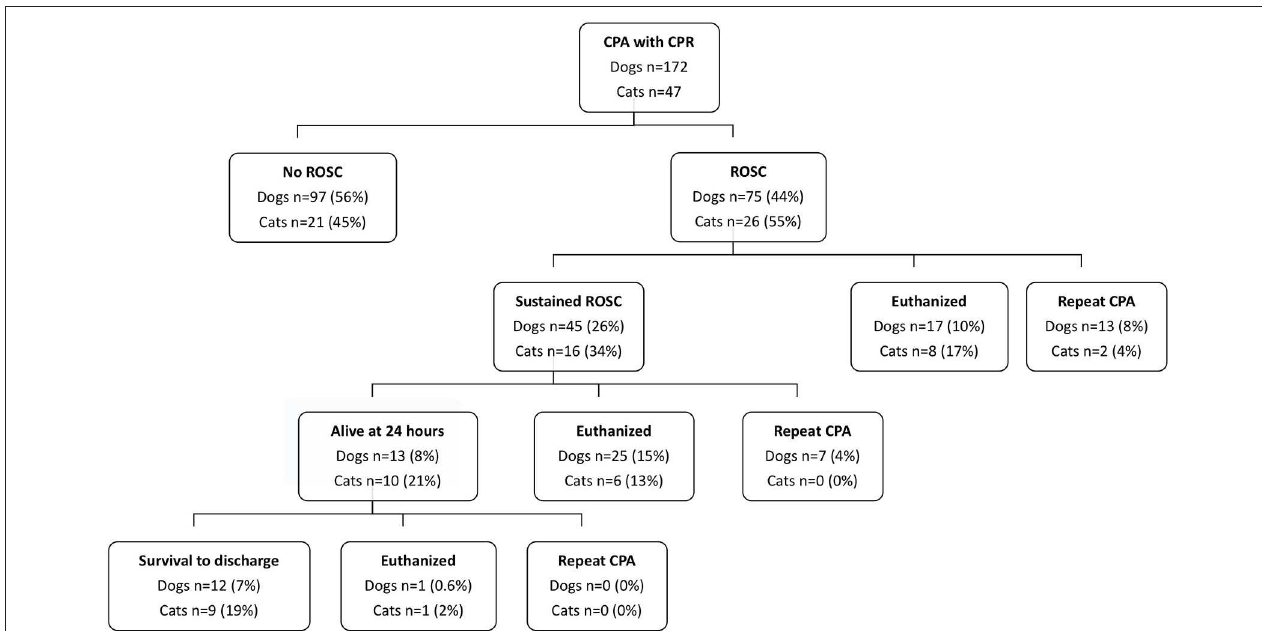
FIGURE 1 | Outcome data for dogs and cats that suffered cardiopulmonary arrest and underwent cardiopulmonary resuscitation efforts. CPA, cardiopulmonary arrest; CPR, cardiopulmonary resuscitation; ROSC, return of spontaneous circulation.